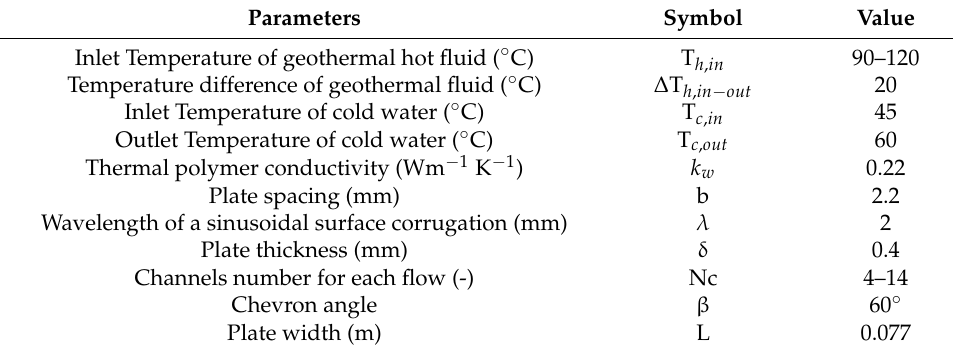
Figure 4. Geothermal heating direct process. Figure 4 . Geothermal heating direct process. Table 3. Input Table 3. Input Data.